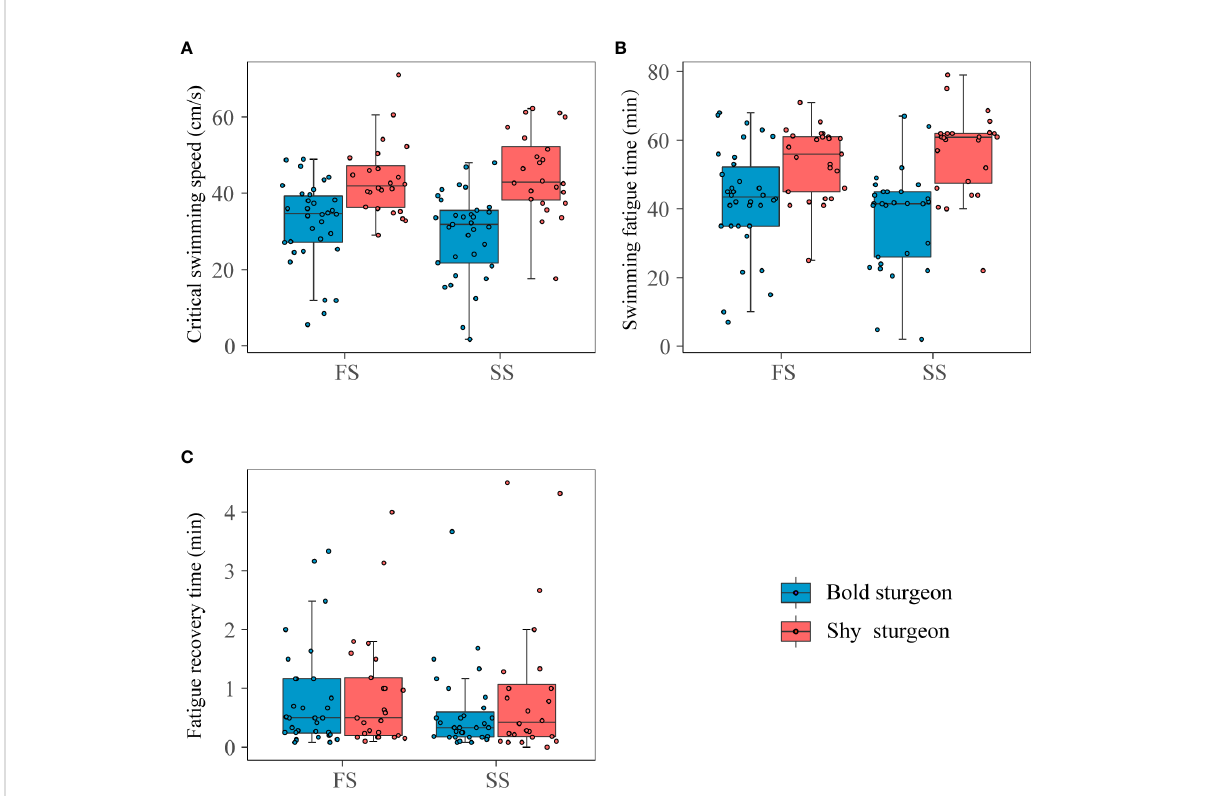
FIGURE 5 Swimming performance of different personalities. Blue and red represented bold sturgeon and shy sturgeon respectively; FS and SS represented the fi rst and second swimming performance test respectively. (A) was the critical swimming speed, (B) was the swimming fatigue time (endurance), and (C) was the fatigue recovery time.